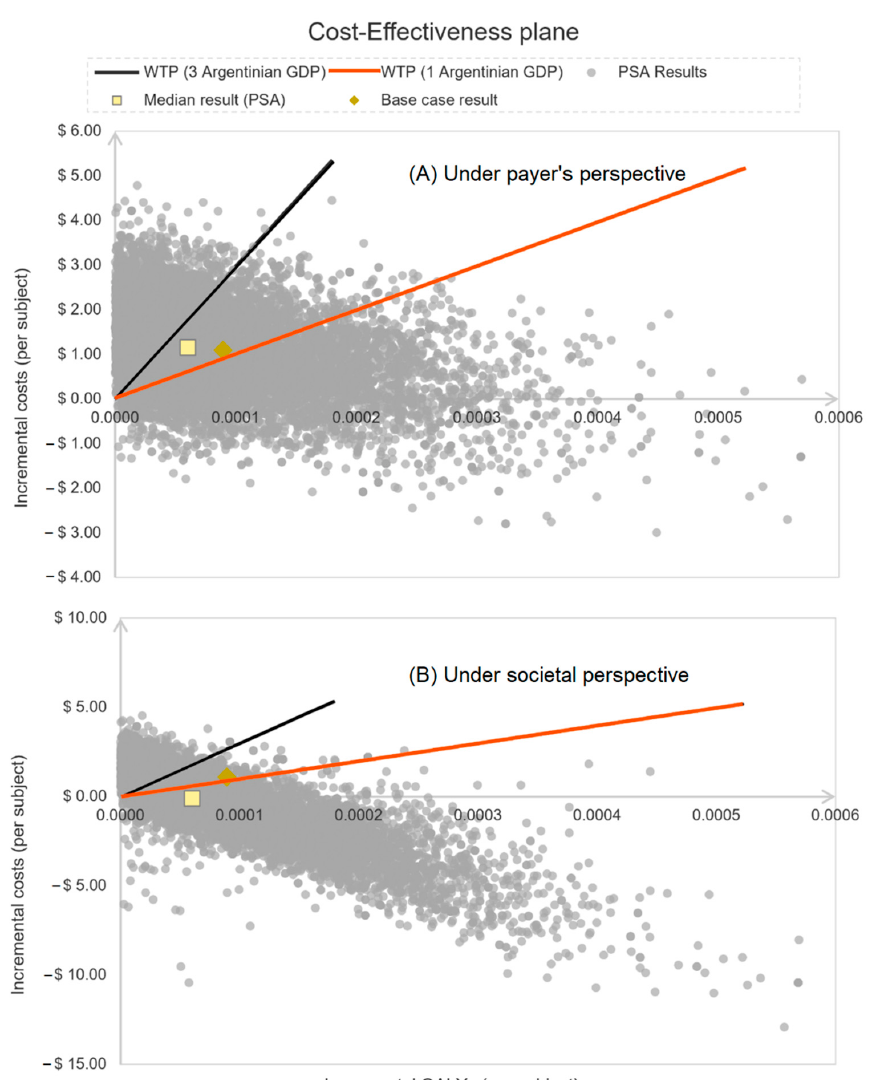
Figure 5. Cost-effectiveness plane of QIVc vs. QIVe comparison.